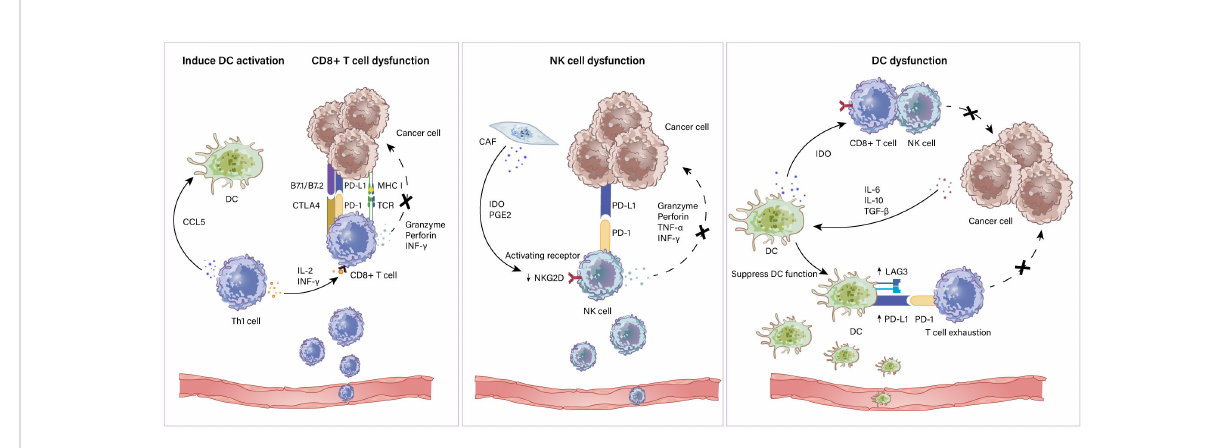
FIGURE 2 Immunoactivated cells in the TME. Immune activated cells include CD8+ and CD4+ T lymphocytes, NK cells and DCs. Th1 cell which is a subtype of CD4+ T cells express CCL5 to induce DC activation and produce IL-2 and IFN- g to assist CD8+ T cells. CD8+ T cells recognize antigens expressed on MHC class I on cancer cells leading to the cytotoxic killing of cancer cells via granzymes and perforins. CD8+ T cell dysfunction is mediated by elevated inhibitory ligand PD-L1 and B7 molecules on cancer cells. NK cell dysfunction mechanisms include (i) PGE2 and IDO derived from CAFs downregulate the expression of activating receptor NKG2D on DCs; (ii) inhibitory ligand PD-L1 and B7 molecules expressed by cancer cells restrain NK cell function by combining with PD-1 and CTLA-4. The mechanism of impaired DC function includes (i) overexpression of PD-1 ligands and LAG3 on DCs results in T cell exhaustion; (ii) IL-6, IL-10 and TGF- b produced by cancer cells alter DC maturation and migration